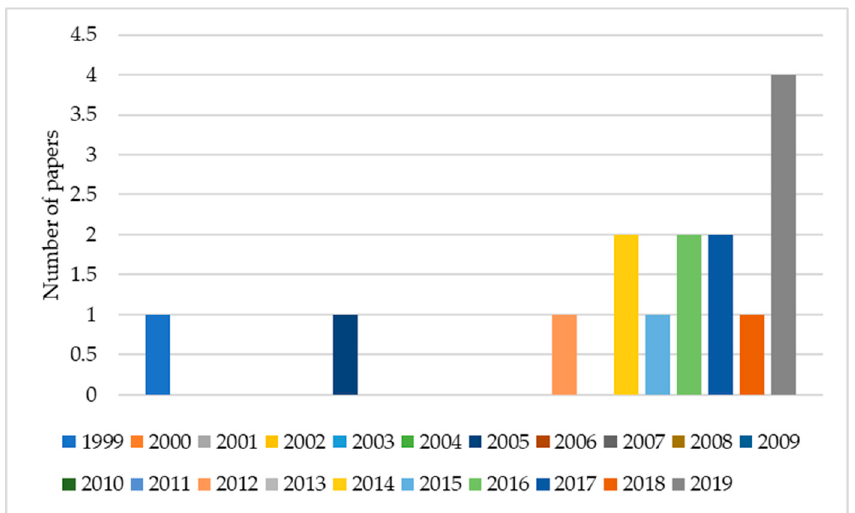
Figure 7. Distribution of review articles per year.